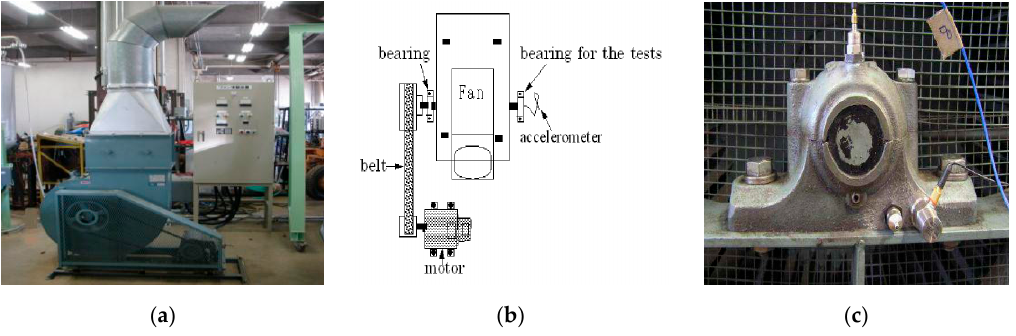
Figure 7. ( a ) Fan system ( b ) Flow diagram of the fan system ( c ) Location of the sensors.